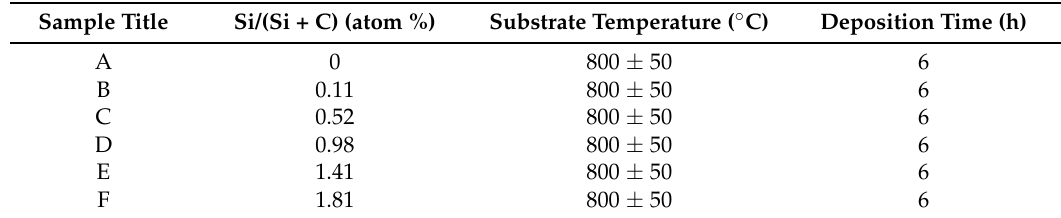
Table 1. Detailed deposition